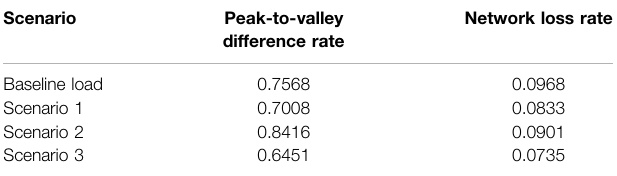
TABLE 2 | Total load indicators in different scenarios.